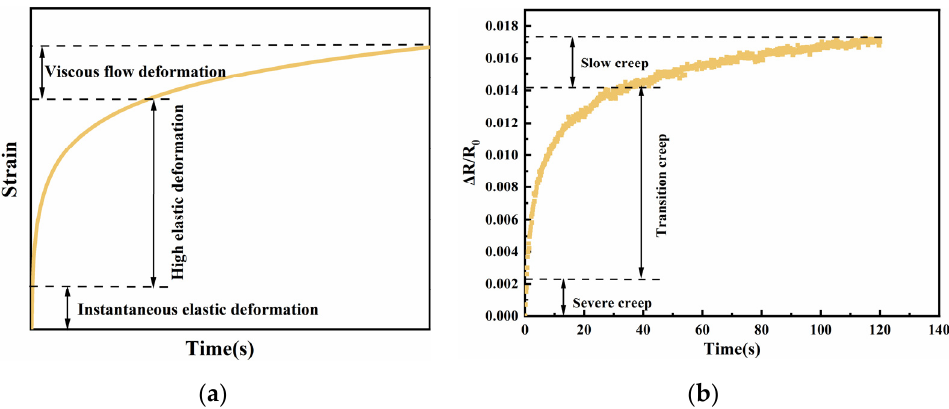
Figure 4. ( a ) Typical strain vs. time diagram at constant pressure. ( b ) Resistance change vs. time plot at 160 kPa constant pressure.